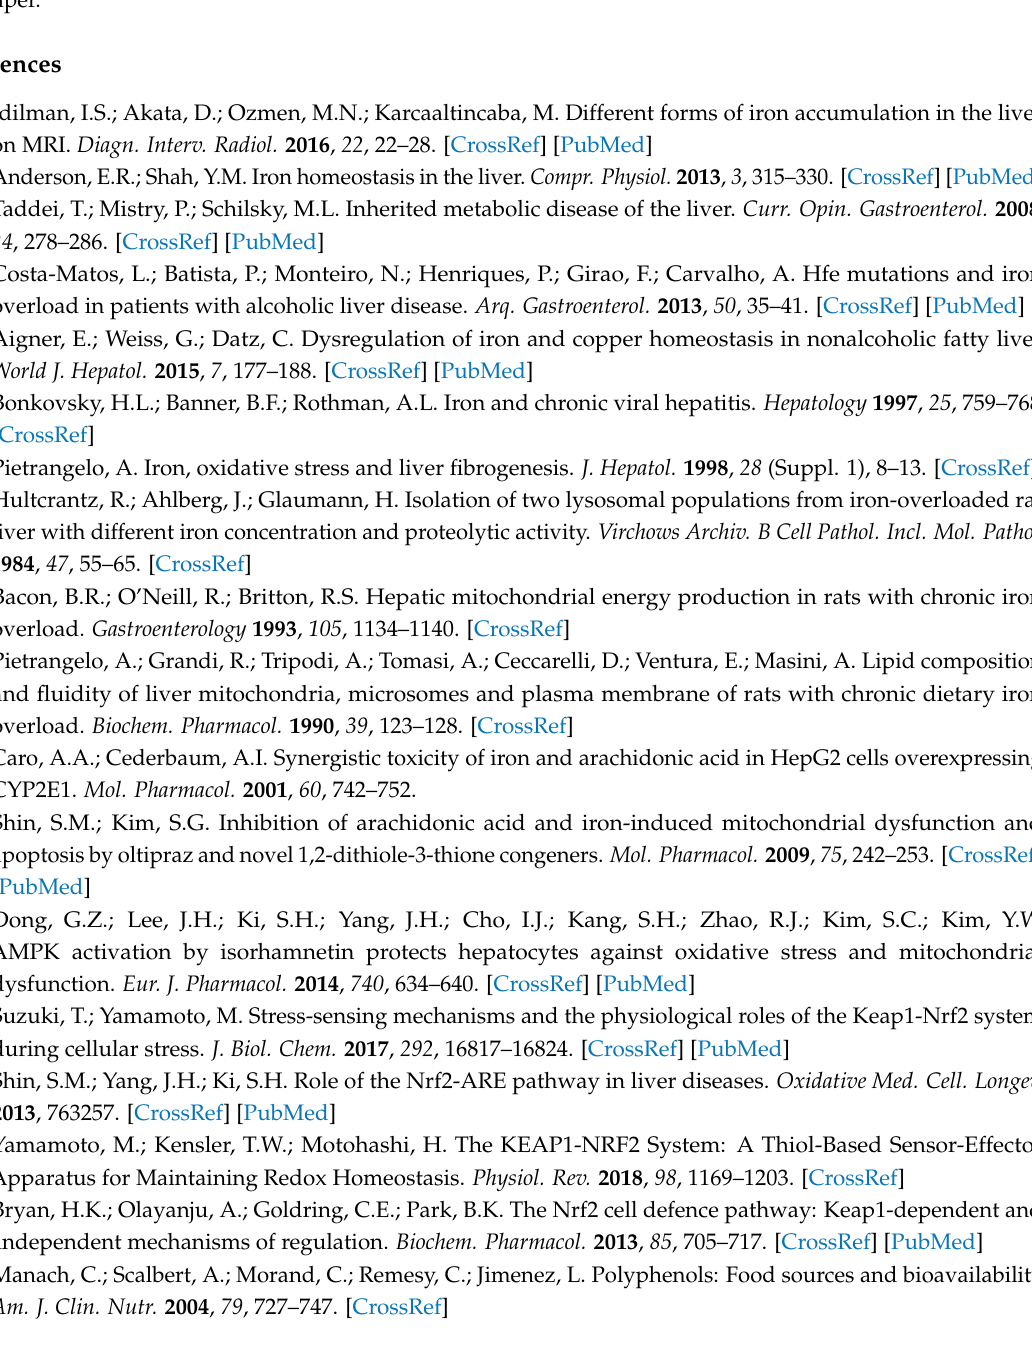
Figure S1: Cell viability due to P. bambusoides (PB) and P. nigra var. henonis (PN) extracts in HepG2 cells. ( A and B ): HepG2 cells were treated with extracts of PB (PB1-5: 100 µ g/mL) and PN (PN1-5: 100 µ g/mL) for 24 h. Data represent the mean ± S.D. of 3 separate experiments, where the statistical significance of differences